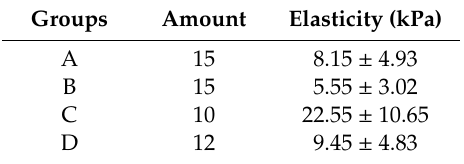
Table 4. The Young’s modulus of the oocytes from four